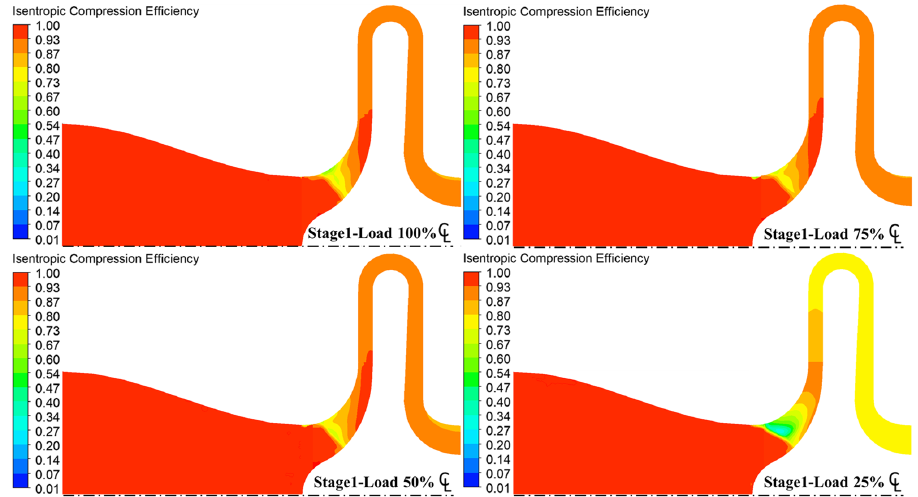
Figure 18. Meridional contour maps of the first stage compression isentropic efficiency with R-513A refrigerant under various loads.